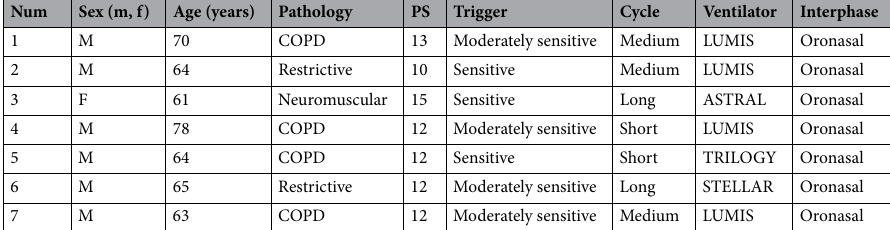
Table 4. Characteristics and devices of the patients included in the clinical study.